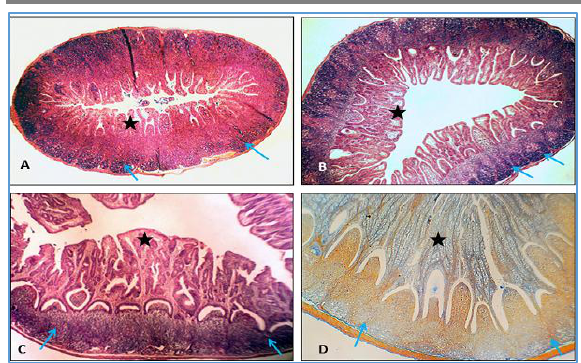
Figure, 3: Microphotograph through the wall of SR at different postnatal ages: A (1days), B (10 days), C (15days) and D (40 days). Note the shape of villi (black stars) and development of lymphoid follicles (blue arrows). X40, (A, B, C) H and E, (D) Mallory Trichrome stain.